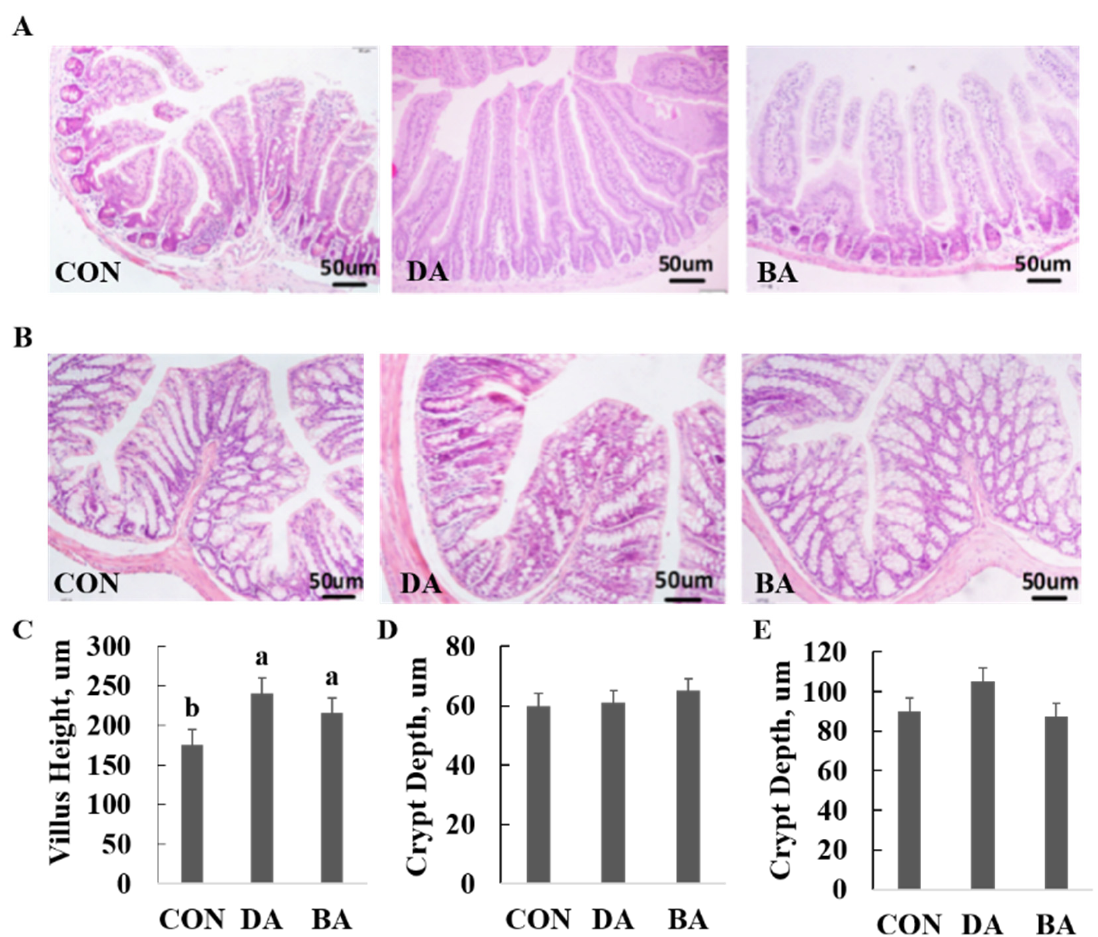
Figure 2. Effects of sodium decanoate and sodium butyrate on intestinal morphology in the ileum and colon of C57BL/6 mice (Exp. 2). ( A ) The representive image ( n = 6). Intestinal morphology of the ileum in mice using H&E staining. ( B ) The representive image ( n = 6). Intestinal morphology of the colon in mice using H&E staining. ( C ) Villus height of the ileum. ( D ) Crypt depth of the ileum. ( E ) Crypt depth of colon. A total of 36 mice with weaning age of 28 d were allocated into three dietary treatments randomly, which are control (CON), 5 g/kg sodium decanoate (DA), and 5 g/kg sodium butyrate (BA) diets. At the end, the intestinal tissue sample from each mouse was collected from the approximately middle positions in the ileum and colon to evaluate intestinal morphology. a,b Significant differences are indicated by different lowercase letters ( p < 0.05).